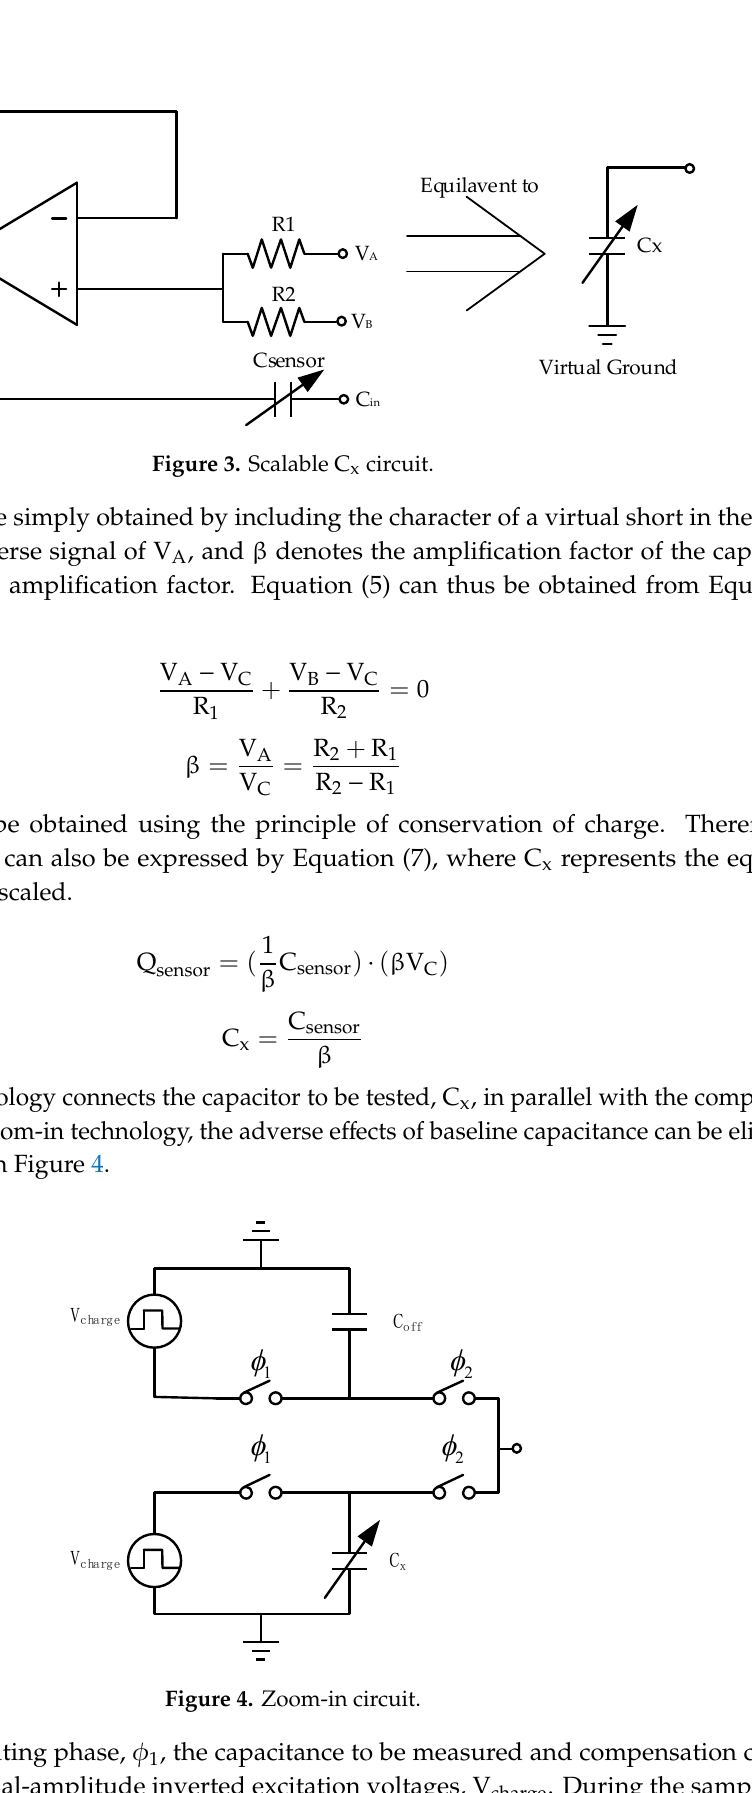
Figure 4. Zoom-in circuit.